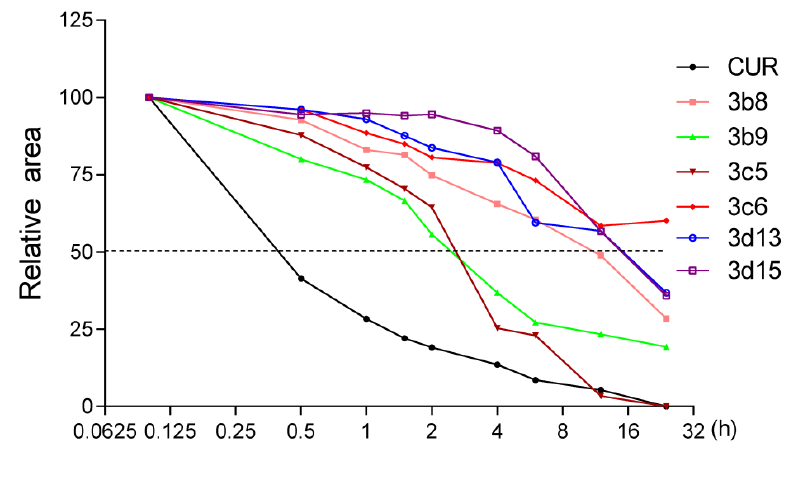
Figure 4. The stability analysis of curcumin and its analogs by HPLC.